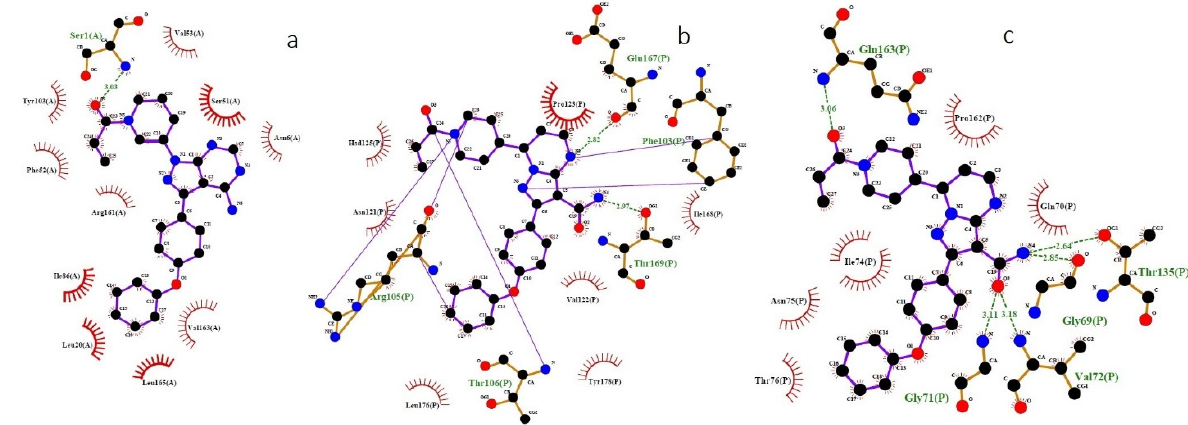
Figure 2. Binding interactions of ibrutinib and zanubrutinib and the structural proteins of SARS-CoV-2 (SRBD, membrane protein and nucleocapsid phosphoprotein) predicted by LigPlot. ( a ) Interaction of the N atom of Ser1 in the SRBD and the O atom of ibrutinib. ( b ) Interaction of the O atom of Glu167 in the membrane protein and the N atom of zanubrutinib. ( c ) Interaction of the O atom of GLY69 and THR135 in the nucleocapsid phosphoprotein and the N atom of zanubrutinib. SRBD—spike protein receptor-binding domain; O—oxygen; N—nitrogen; blue lines—ligand bonds; orange lines—non-ligand bonds; dotted lines—hydrogen bonds and their length; red semicircles—non-ligand residues involved in hydrophobic contacts; black dots—corresponding atoms involved in hydrophobic contacts.